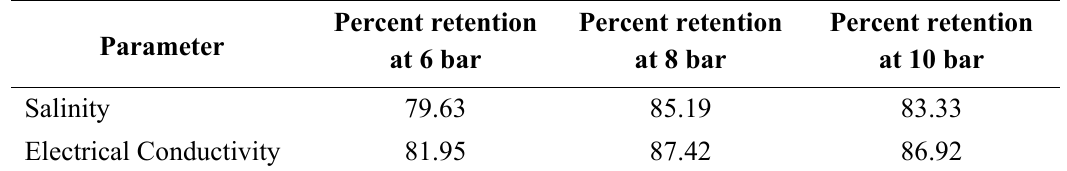
Table 8. Retention percentage (% R ) of salinity and electrical conductivity at various pressures for Sample 2.